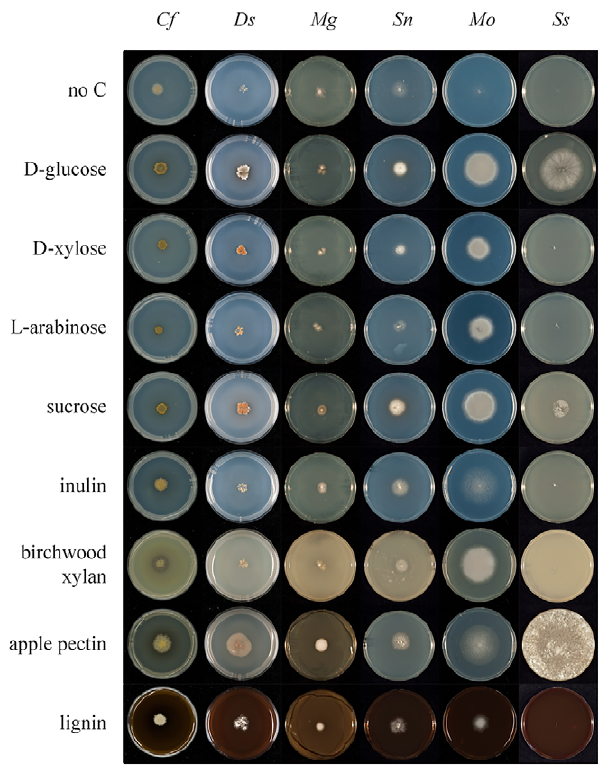
Figure 6. Comparative growth profiling of fungi on various carbohydrate substrates. Growth on different substrates was compared between six fungi on nine media to highlight differences. Cf , C. fulvum ; Ds , D. septosporum ; Mg , M. graminicola ; Sn , S. nodorum ; Mo , Magnaporthe oryzae ; Ss , Sclerotinia sclerotiorum . D-Glucose, D- xylose, L-arabinose and sucrose were added at a final concentration of 25 mM. Birchwood xylan, apple pectin and lignin were added at a final concentration of 1%